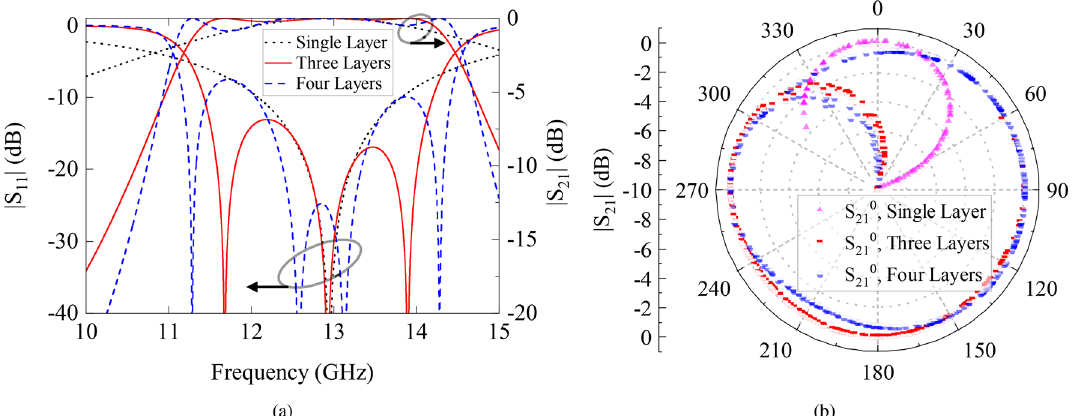
Figure 2. ( a ) Reflection and transmission characteristics of a DF-PSC with multiple identical metal layers, and ( b ) The transmission magnitude and phase of DF-PSCs on a polar